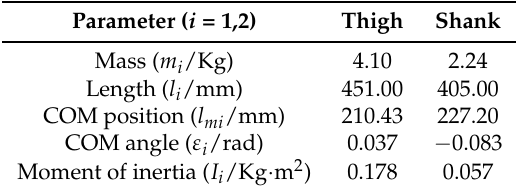
Table 1. The parameters of the thigh and shank